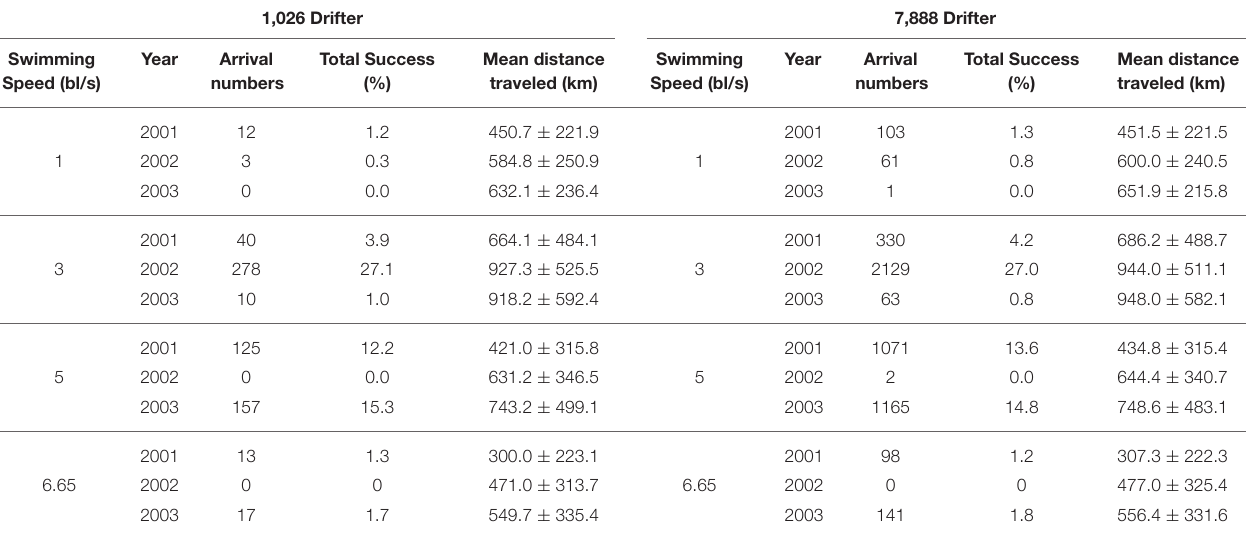
TABLE 2 | The results of the statistical reliability study releasing 1,026 vs. 7,888 drifters from the northwestern Shelf on October 30th in years 2001, 2002, and 2003 in the temperature gradient simulations with 1–6.65 bl/s swimming speed for anchovy of 10 cm